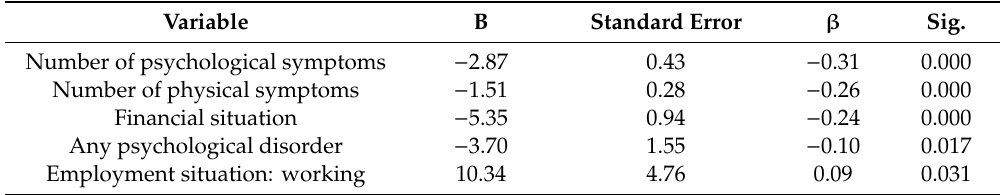
Table 5. Regression model for the dependent variable “WHOQoL BREF